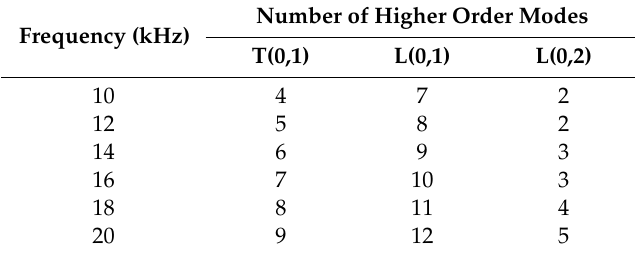
Figure 7. Experimental results over ( a ) time and ( b ) range of frequency for excitation at a different number of transducers, illustrating the incremental amplitude increase when the number of transducers increased. Table 3. Number of flexural modes corresponded to each family of fundamental modes over a range of frequencies.